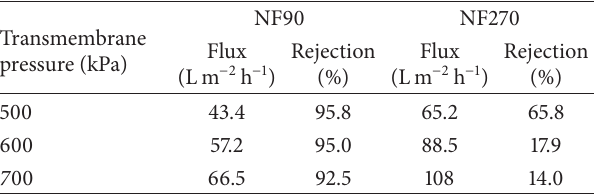
Table 5: Influence of transmembrane pressure on dimethyl phtha- late rejection and permeate flux (the feed solution